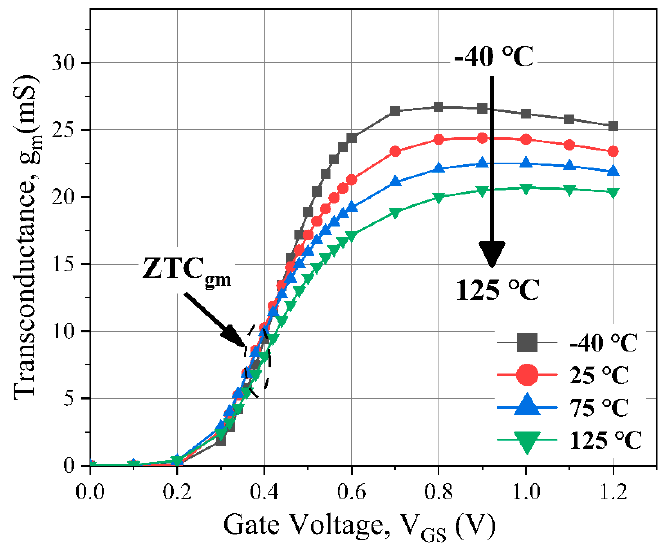
Figure 5. Simulated g m vs. V GS at different temperatures.